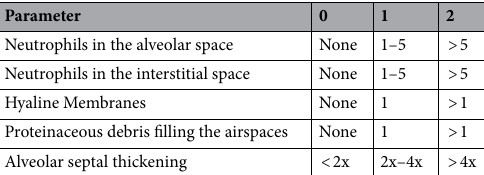
Parameter 0 2 Neutrophils in the alveolar